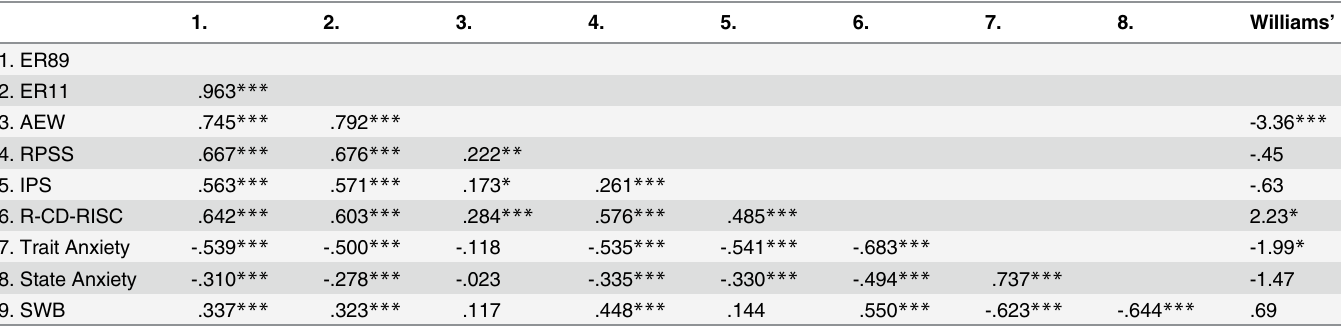
The hierarchical multiple regression models of ER11 and R-CD-RISC (see Table 7) showed that ER11 did not contribute to the explained variance if it was included in second step of the analyses or it lost its significant effect after R-CD-RISC was included in the model in case of State Anxiety, Subjective Well-Being, Negative Affect (last week), General Self-Efficacy, and the Big Five traits of Agreeableness and Conscientiousness. In some models, both predictors contributed to the explained variance, but R-CD-RISC had a greater coefficient in the case of Table 5. Inter-correlation matrix for Study 2 – Sample 1 and comparison of the correlations of the ER11 and ER89 scales.